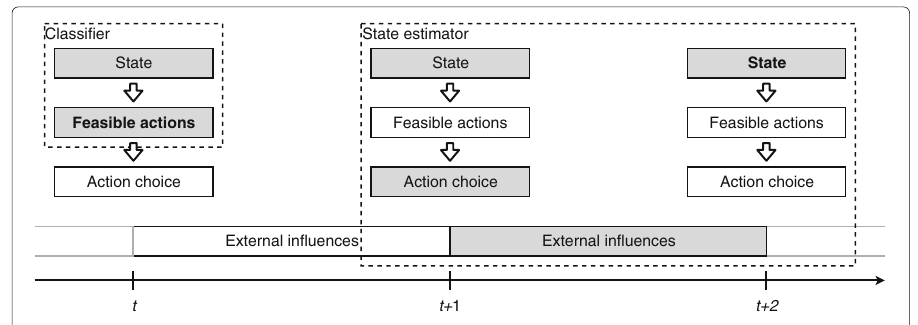
Fig. 3 Data required for training the models. State, feasible actions and the action choice are collected at discrete points in time, while external influences accumulate over time. Classifier and stateestimator do not overlap in this depiction solely for the sake of